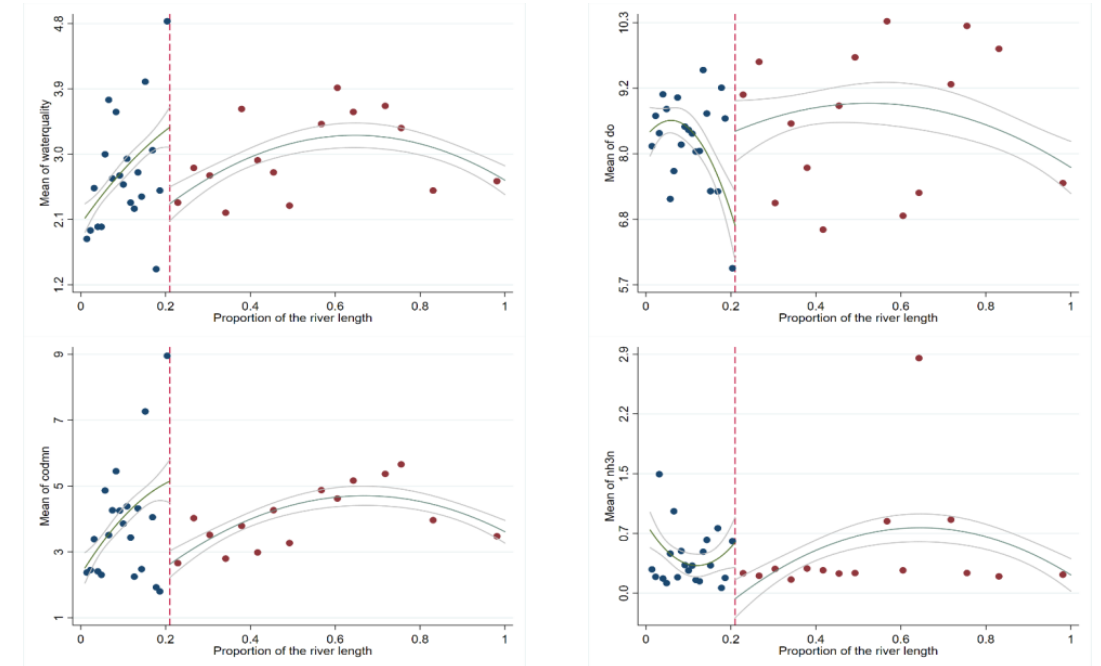
Figure 3. The discontinuities in the proportion of the river length after the implementation of RCS. Note: The x-coordinate represents proportion of the river length, and the y-coordinate represents water quality.